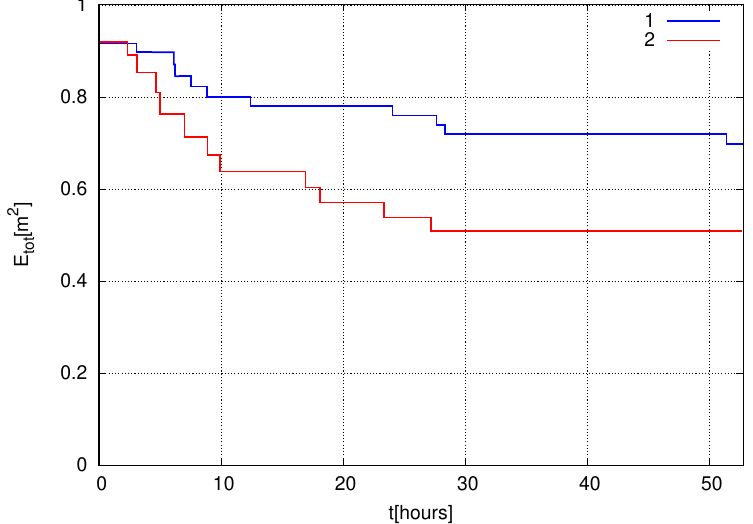
Figure 18. Dependence of the total energy E tot on simulation time for numerical experiments with µ = 0.06 and ˜ k p = 1 in different models. The blue solid line 1 corresponds to the SCZ equation and the red solid line 3 to the RV equations.